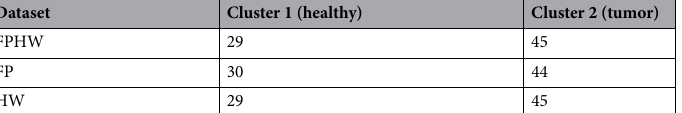
Table 2. Number of spectra in cluster 1 (healthy) and cluster 2 (tumor) generated by k-means unsupervised clustering.